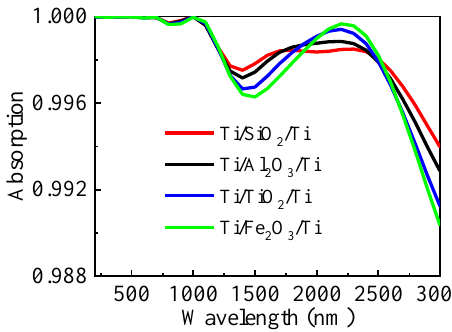
Figure 9. Simulation results of different materials by keeping metal Ti unchanged and replacing the SiO 2 dielectric film with Al 2 O 3 , Fe 2 O 3 , and TiO 2 .